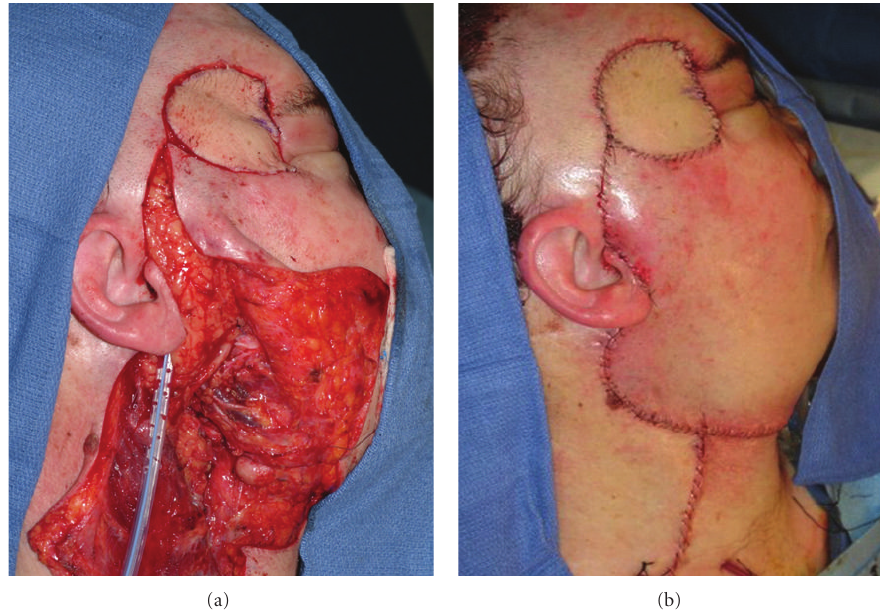
Figure 4: (a) Radial forearm free tissue transfer reconstruction after microvascular anastomosis. (b) Closure. Note excellent skin color match and thin pliable soft tissue in the temporal region avoiding bulky aesthetics and unnecessary lateral canthal traction. Due to the advanced nature of the primary lesion, postoperative radiotherapy was administered to the primary site and parotid bed. At last followup, the patient was alive without evidence of distant disease or local